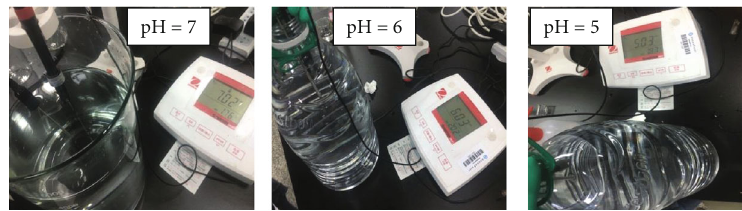
Figure 3: Preparation of hydrochloric acid solutions with di ff erent pH values.